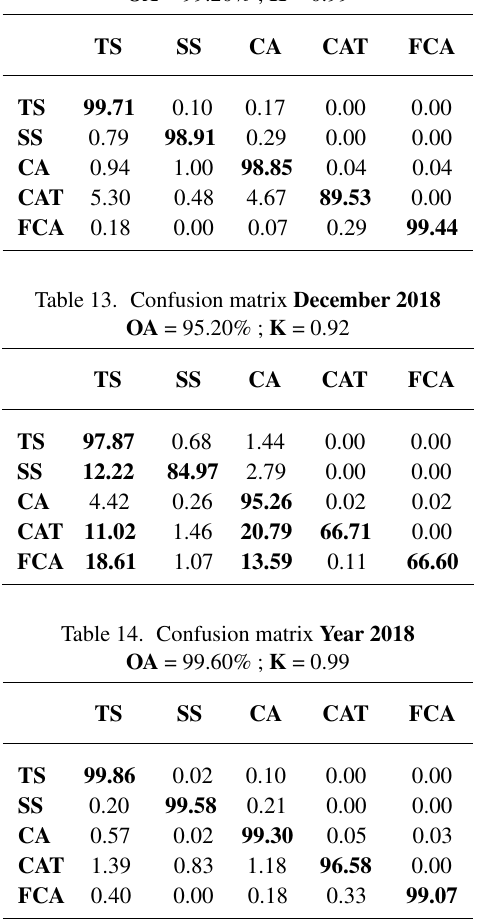
Table 12. Confusion matrix November 2018